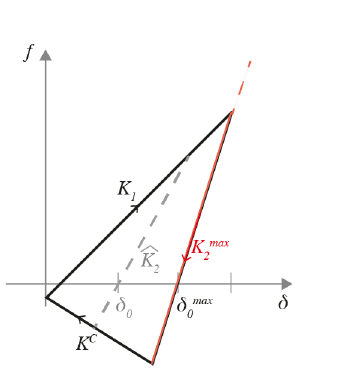
Figure 2. Regime map for three di ff erent sintering mechanisms. First, an adhesive equilibrium is modelled before point p 1 , fol- the 0 lowing the JKR fl at zone. From point p 1 to point p 2 , it is de fi ned the starting point at which the instantaneous compliance of the material takes place, and after point p 2 , the material is su ffi ciently relaxed to fl ow under surface